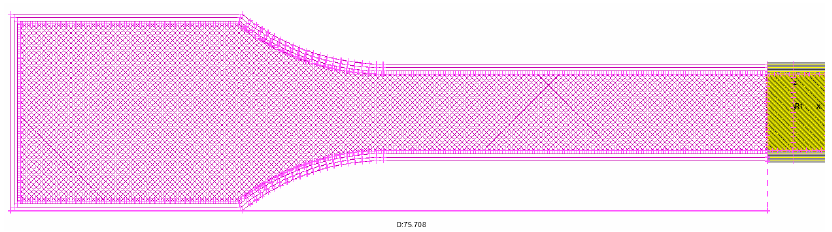
Figure 3. Cross-section distance from the edge of the tensile specimen.